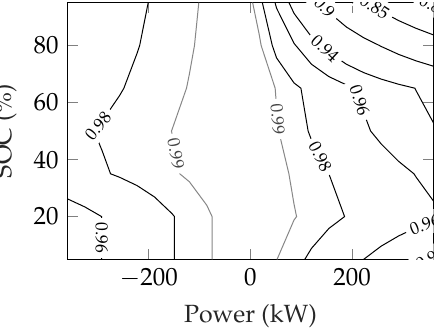
Figure 6. Efficiency of a 200 kWh battery. Negative power indicates discharging.